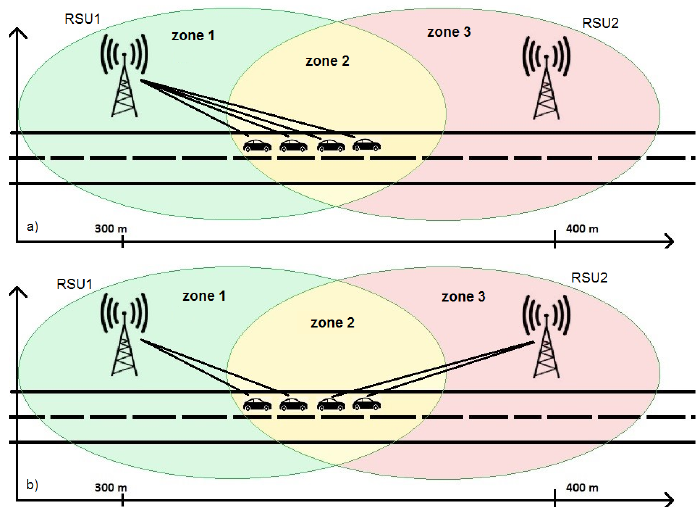
Figure 5. Switching mechanism: ( a ) without cell breathing-like approach; and ( b ) with cell breathing- like approach.